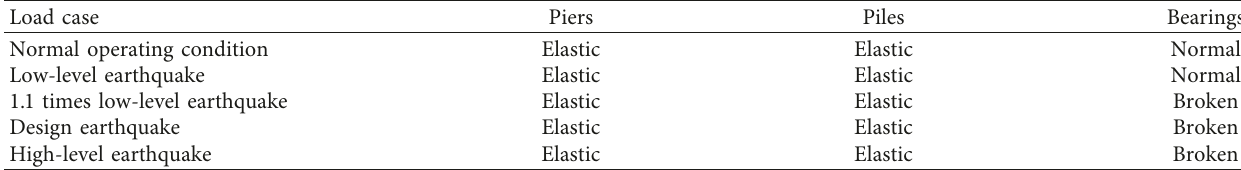
Table 7: Mechanical status of different components with isolation devices.